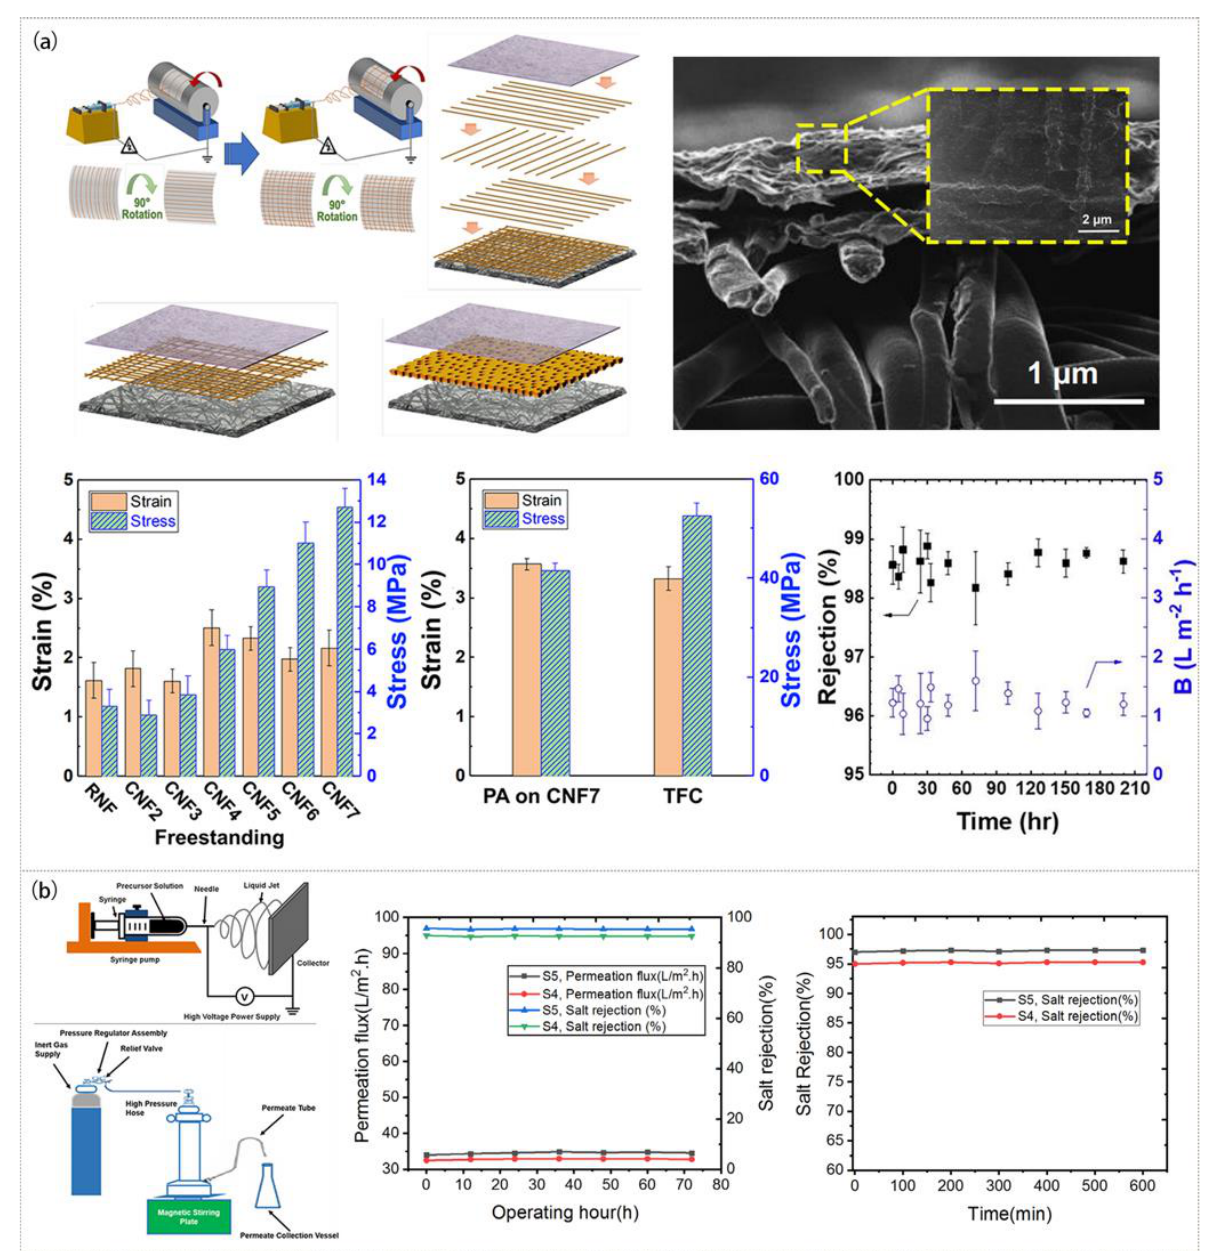
Figure 6. Preparation process, microstructure, and properties of RO membranes: ( a ) PA membrane. Reprinted with permission from Ref. [93]. Copyright 2020 American Chemical Society. ( b ) PVA/ZnO membrane. Reprinted with permission from Ref. [94] Copyright 2019 John Wiley and Sons, Inc.